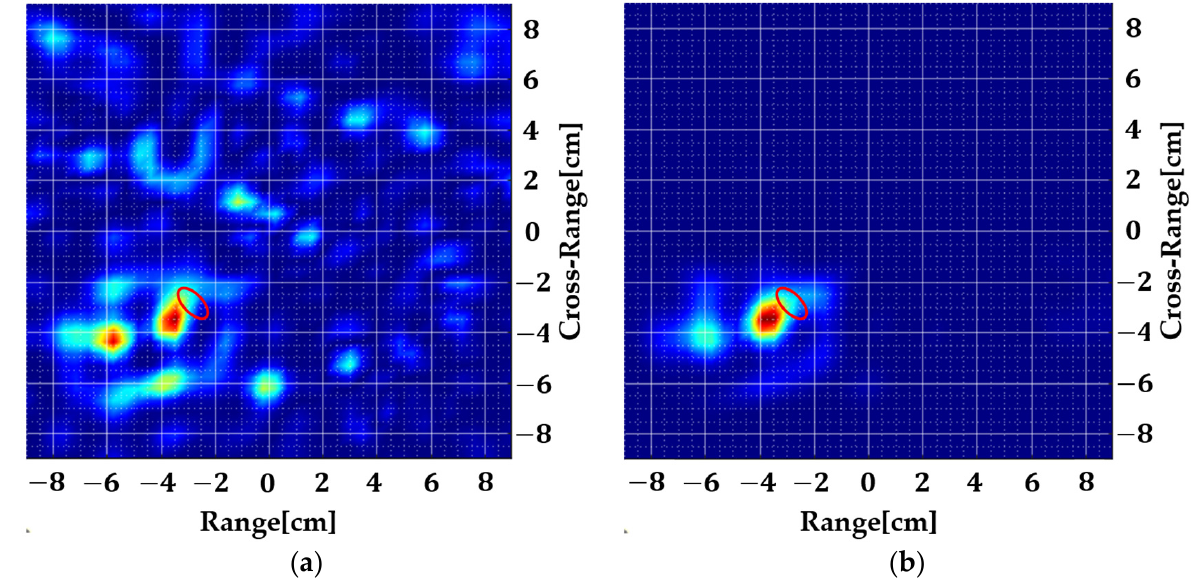
Figure 11. Simulated images of the dielectric anomaly where the red ellipse is the true location. ( a ) Without spatial smoothing and ( b ) with spatial smoothing ( m = n = 5).